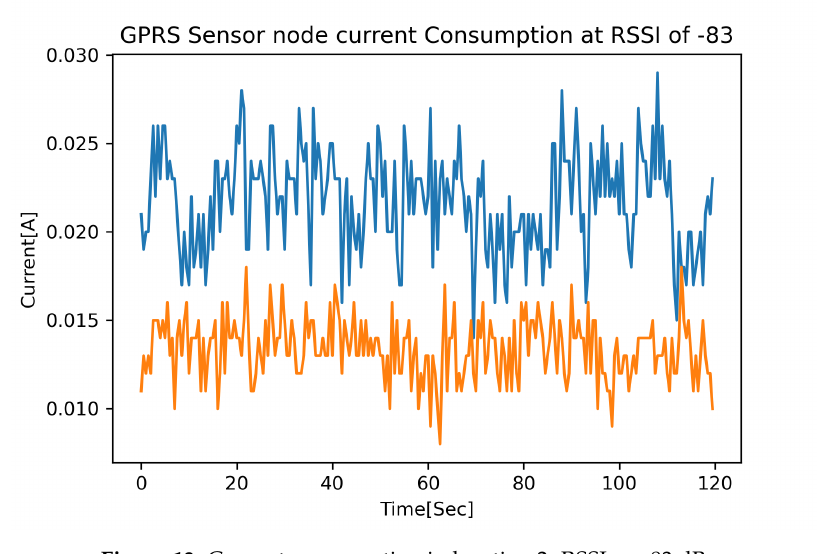
Figure 13. Current consumption in location 2: RSSI = − 83 dBm.